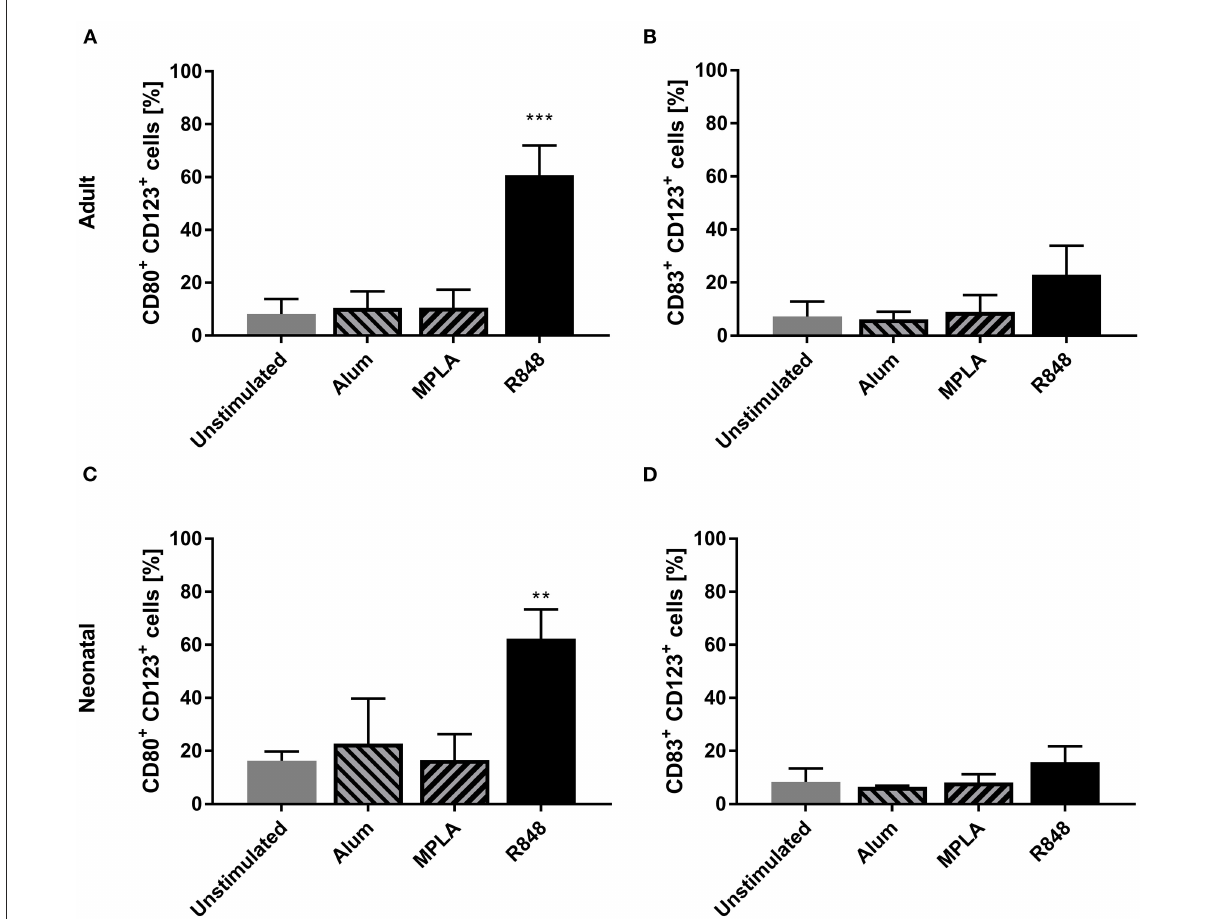
FIGURE2 Effect of different adjuvants on CD123 + pDC activation. Adult (A,B) and neonatal (C,D) DCs were incubated with or without alum, MPLA or R848 for 20h. Flow cytometric analysis of CD80 (A,C) and CD83 (B,D) expression by CD1c + DCs after stimulation. Data represent the means ± SD ( n = 3). Significantly greater than unstimulated control: ** P < 0.001; *** P < 0.005 (one-way